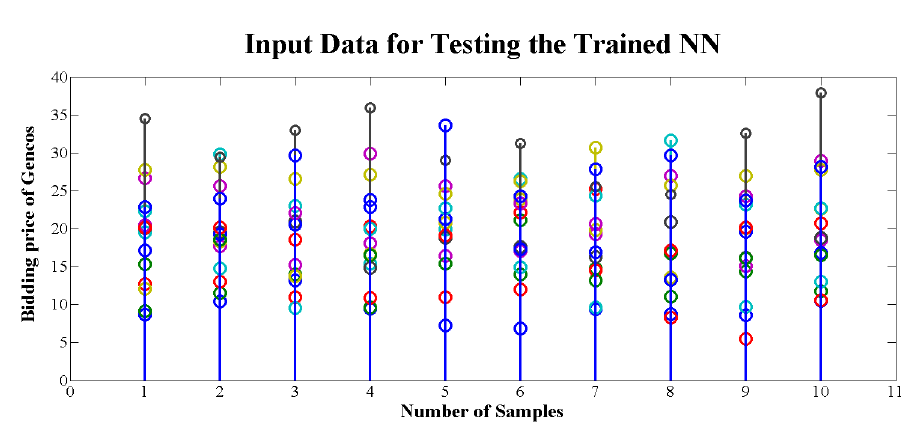
Figure 15. Input data for testing the Trained Neural Network.